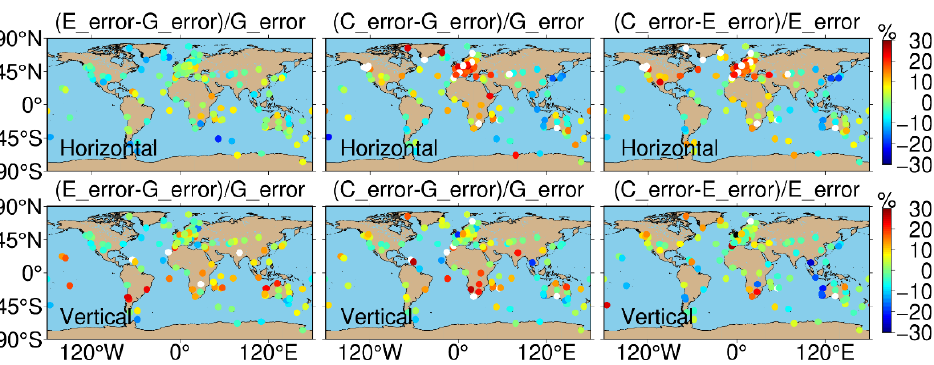
Figure 9. Geographical distribution of the single-frequency positioning accuracy of 145 tracking stations in the horizontal and vertical sections of GPS, Galileo and BDS-3.